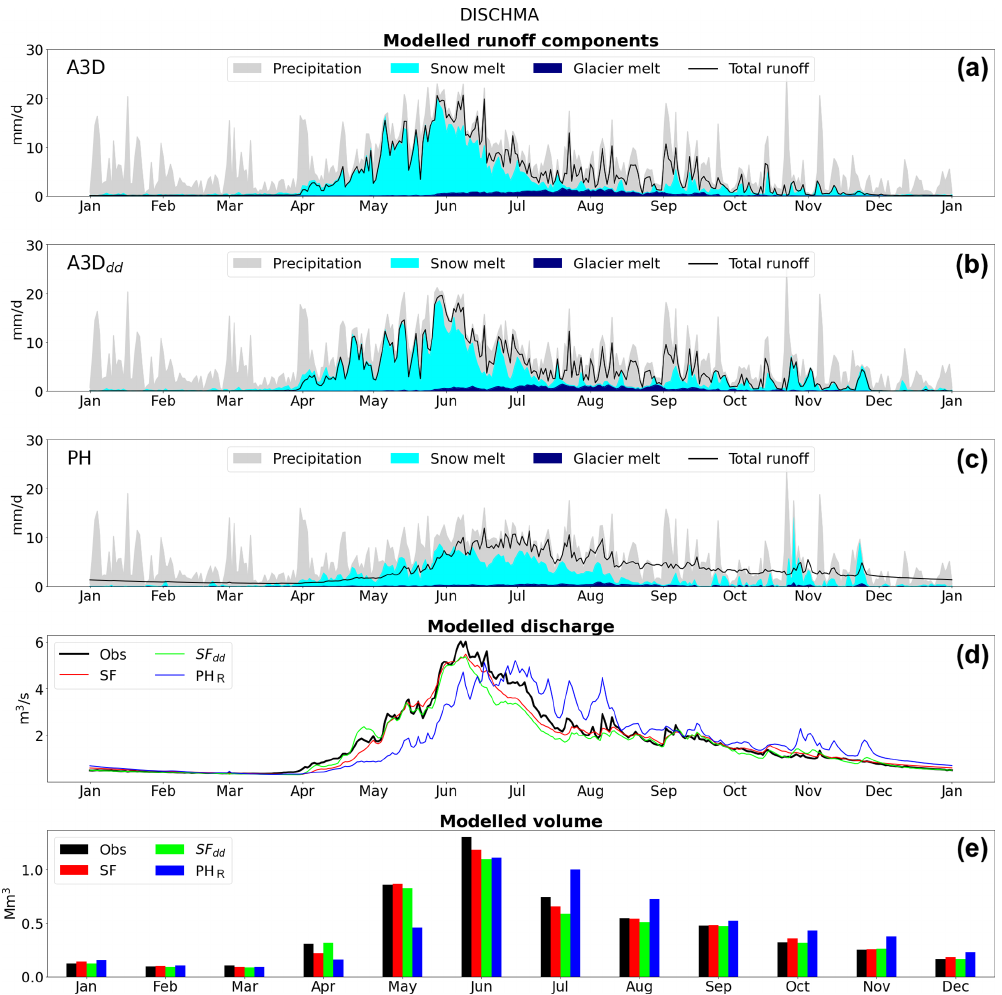
Figure 7. Panels (a–c) : modelled runoff components over the Dischma catchment reproduced with the full solver of Alpine3D (A3D), the degree-day melting scheme of A3D DD and PH, respectively. Panels (d, e) : discharge and monthly volumes modelled by StreamFlow using output from the full solver of Alpine3D (SF) or its degree-day scheme (SF DD ) and modelled by Poli-Hydro (PH R ) compared with measurements. Results for the validation years 2015–2018, averaged by day of the year and by